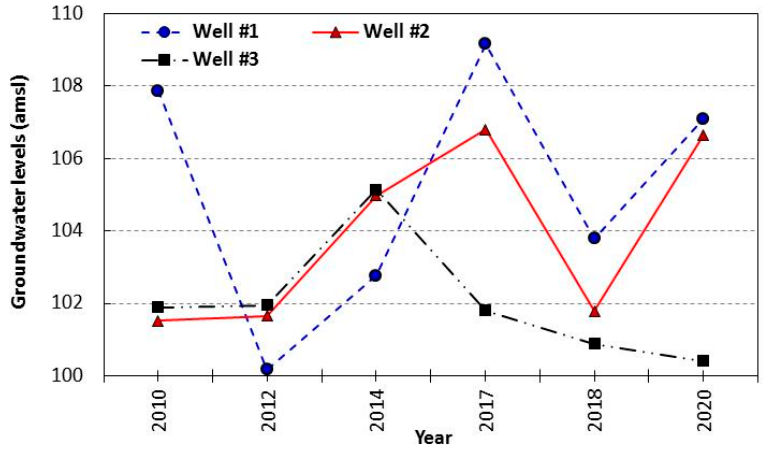
Figure 9. The relation between the groundwater levels in the three wells and different years.